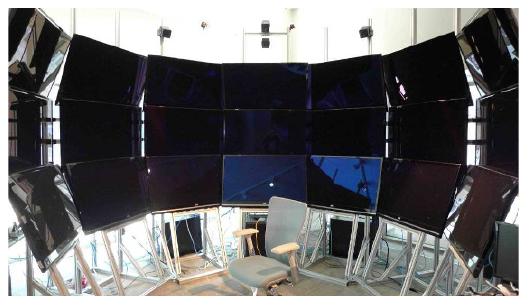
Figure 15. The KAUST NexCAVE turned off to show the structure designed and built by Greg Dawe. Photo: Tom